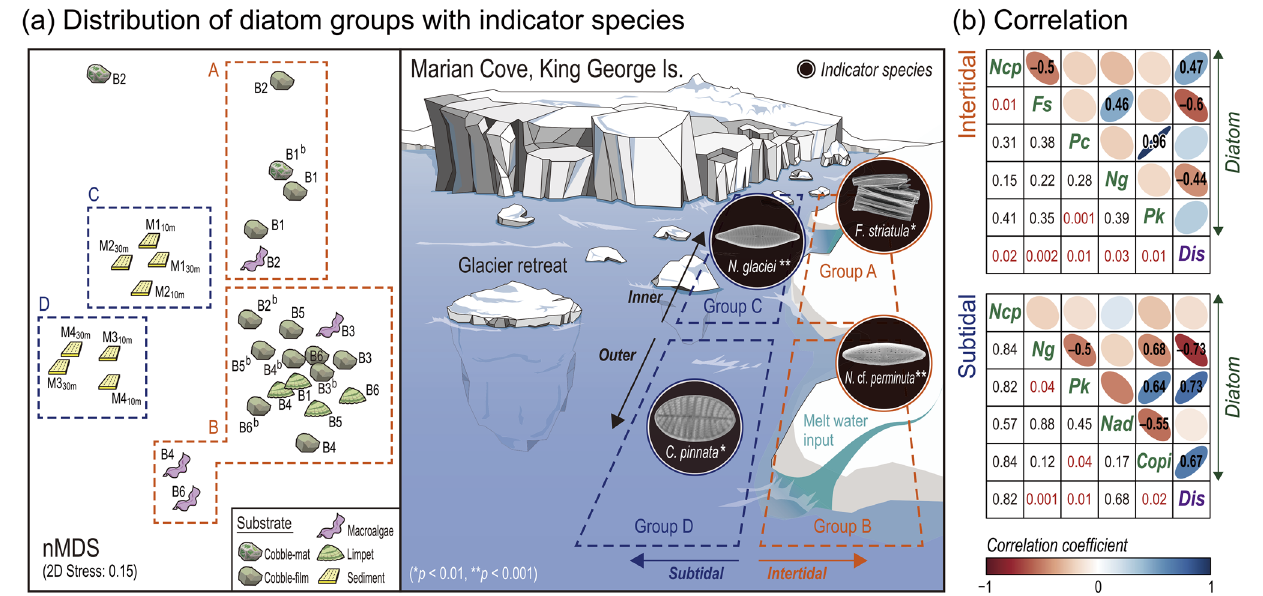
Figure 3. Four indicator species of each environment in Marian Cove, and the correlation between species and distance from the glacier; ( a ) Diagram of the study area with indicator diatom species (SEM images) along the cove and nMDS ordination plot based on relative abundance. ( b ) Correlation between top five dominant species in each intertidal and subtidal zone (Ncp, Navicula cf. perminuta ; Fs, Fragilaria striatula ; A3, Achnanthes sp. 3; N1, Navicula glaciei ; Pk, Pseudogomphonema kamtschaticum ; Nad, Navicula directa ; Copi, Cocconeis cf. pinnata ) and distance from the glacier (Dis). p -values are given as